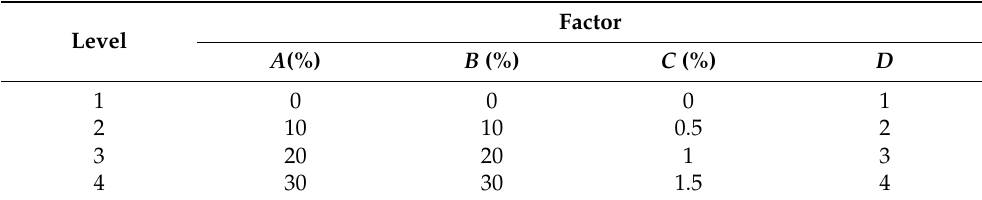
Table 4. The factor levels in the orthogonal